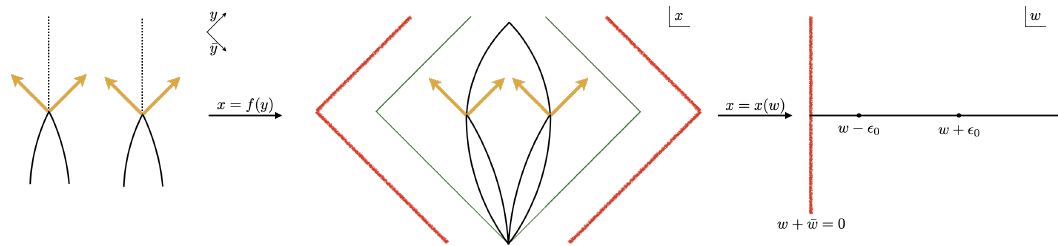
Figure 6. The conformal transformations for the disconnected history. Red lines, as above, are ETW branes, green lines are the causal horizons before gluing, and orange lines are positive energy. All three pictures are in real time. The left-most figure is the y -plane, in which time is the UV time u . The middle figure is the Poincare plane; it is the only Penrose diagram here. The right-most picture is the w -plane, which is just half of R 2 ( w + ¯ w ≥ 0 ); in this plane, the state is the half-line vacuum for all